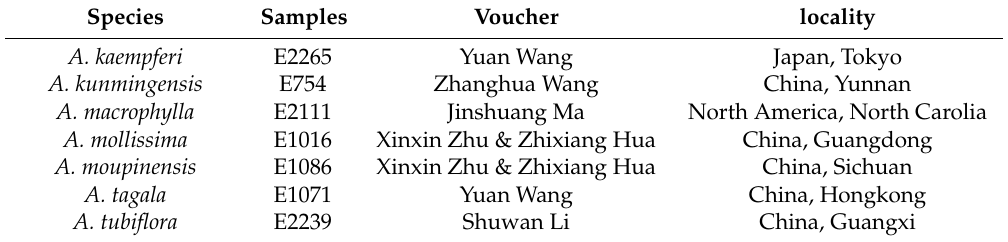
Table 7. Sampled species and their voucher specimens used in this